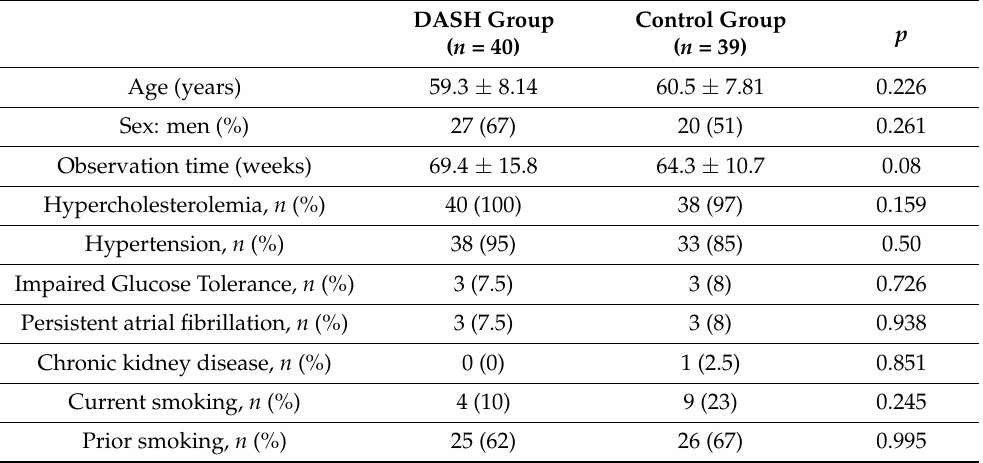
Table 1. Selected characteristics of the study populations.